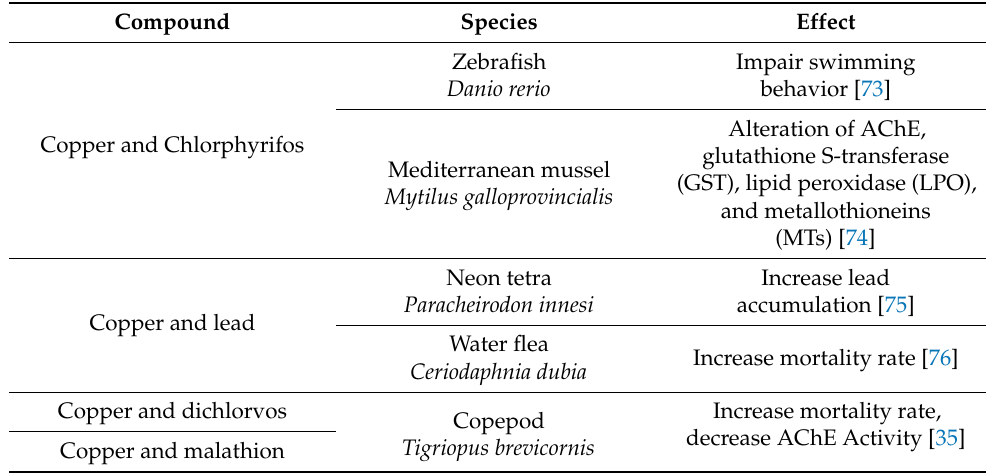
Table A1. Previous study of synergistic effect of copper and pesticide on aquatic